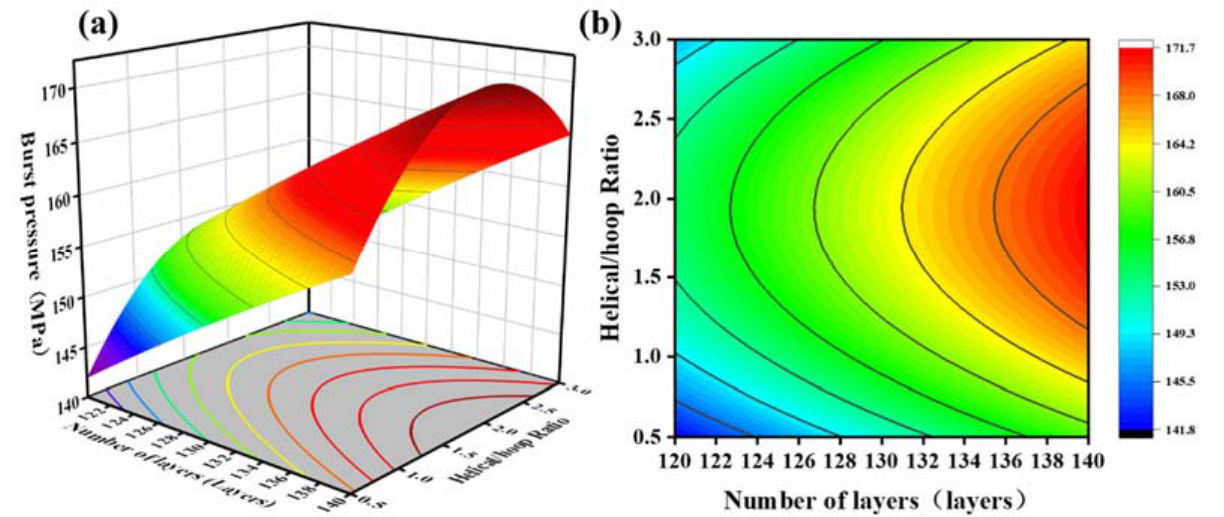
Figure 7. ( a ) Response surfaces of the effect of the helical/hoop ratio and the winding angle on blast ‐ ing pressure; ( b ) contour plot of the effect of the helical/hoop ratio and the winding angle on blasting pressure.